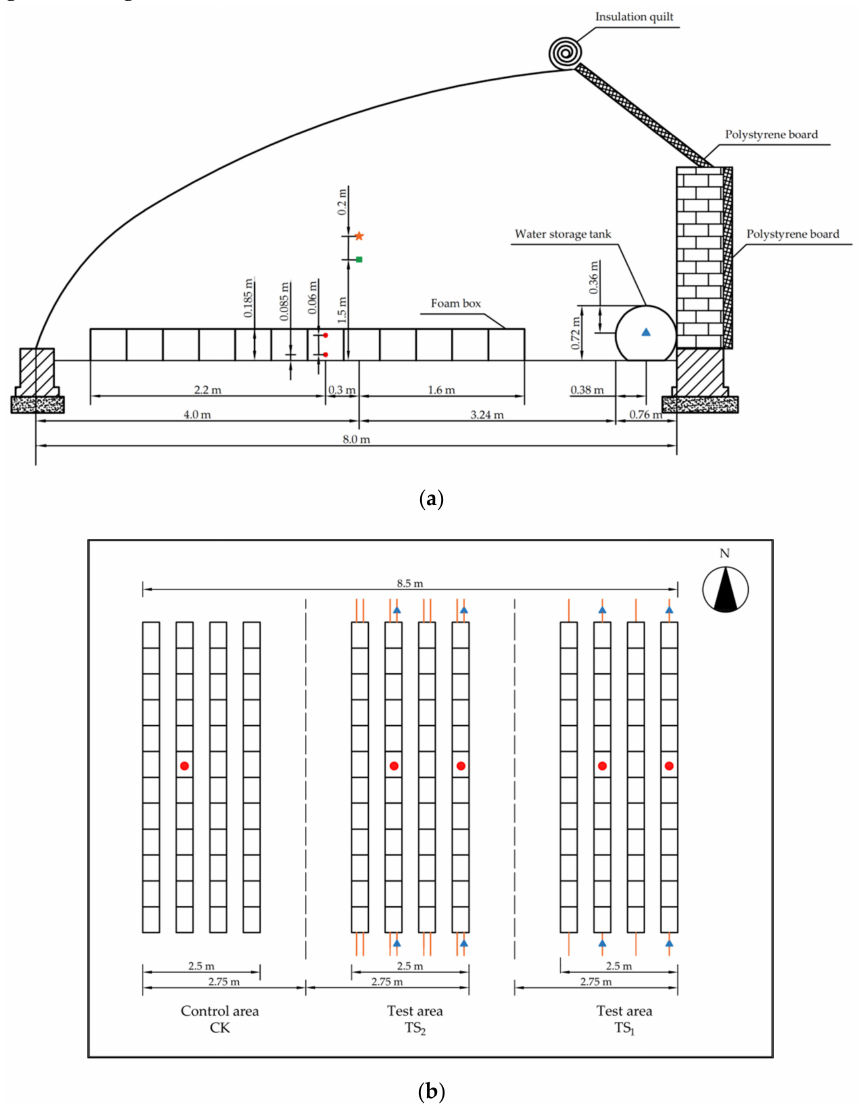
Figure 3. Placement of sensors required for the test. ( a ) The placement of sensors in the vertical direction; ( b ) the placement of sensors on the horizontal plane. is the solar radiation sensor. is the temperature and humidity sensor. is substrate temperature sensor. is the water temperature